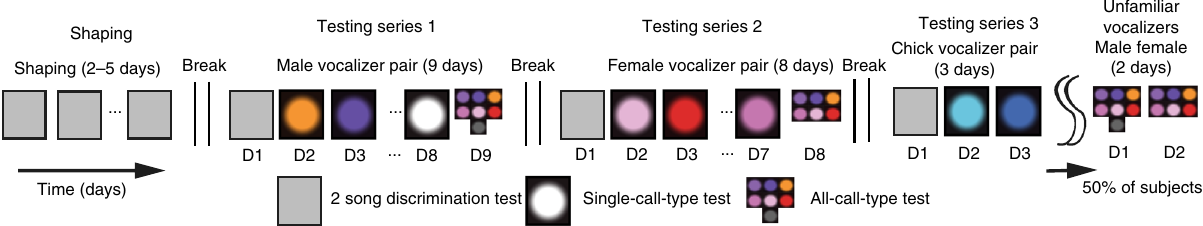
Fig. 2 Typical series of tasks performed across days by single bird subjects. Each square represents a day of testing with the same set of vocalizations. All tests involve the discrimination of a pair of vocalizers and tests were grouped into three series where either two male vocalizers, two female vocalizers or two chick vocalizers were discriminated. The order of the series was randomized. Gray rectangle corresponds to shaping days where birds were trained and tested with two songs from two different males not used in the testing set. Large single-color circles correspond to single-call-type tests: individual discrimination based on multiple renditions of a single-call type (including song for males, gray circle) is tested on each day. The color codes call types. Multiple small circles correspond to all-call-type tests: individual discrimination based on multiple renditions of all call types was tested on each day. Within a series, the order of consecutive tests was also randomized except for the shaping that was always performed fi rst. At the end of the three series, half of the subjects performed all-call-type tests with new pairs of unfamiliar vocalizers. Single-call-type tests, Familiar all-call-type tests obtained in two of the fi rst three series and Unfamiliar all-call-type tests were analyzed